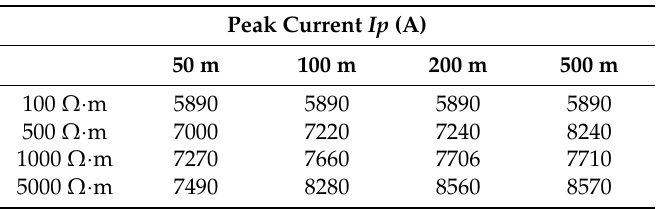
Figure 6. Current time profiles in the copper rope. The distance between the substations is set equal to 50 m. ( a ) soil resistivity 100 Ω · m; ( b ) soil resistivity 500 Ω · m; ( c ) soil resistivity 1000 Ω · m; ( d ) soil resistivity 5000 Ω · m. Table 7. Peak currents in amperes due to a lightning stroke at the beginning of the copper rope between two interconnected MV/LV